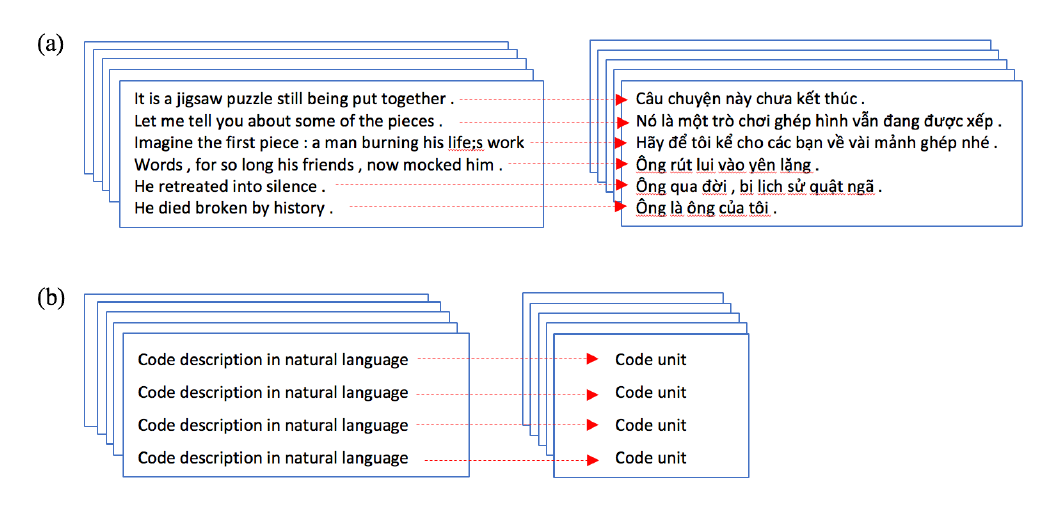
Figure 1. Schematic examples of parallel corpora: ( a ) for NLP translation (source English sentences aligned with target Vietnamese sentences); ( b ) for joint processing of natural and programming